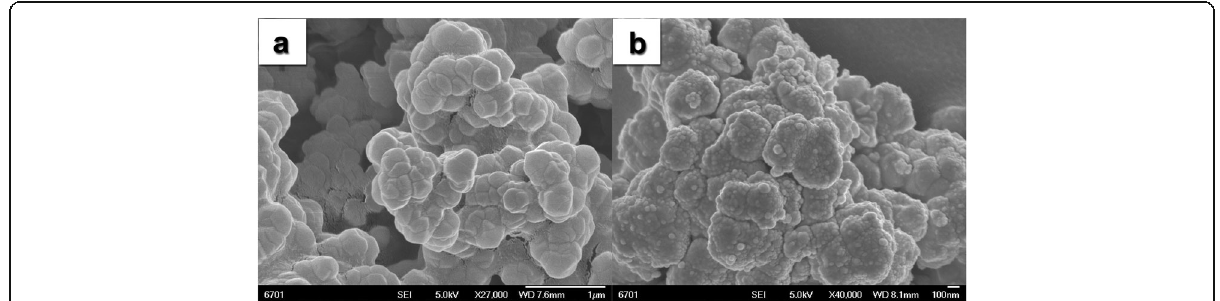
Fig. 1 The typical scanning electron microscopy (SEM) patterns of a UiO-66 and b Pd/MOF